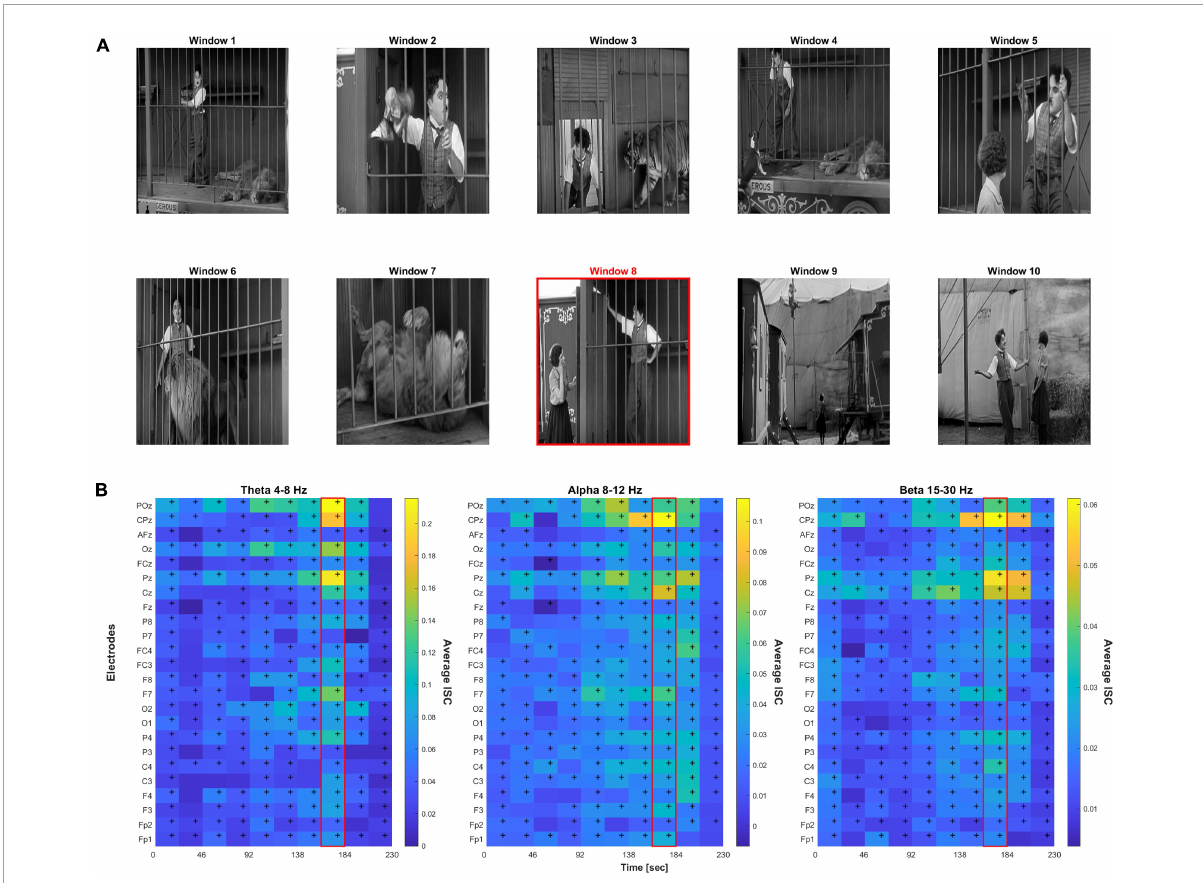
FIGURE1 (A) Screenshots representative of 10 time windows from the film. The red border indicates the peak 8th time window. (B) Heat map of the inter-subject correlation (ISC) values per electrode and time window across three frequency bands; peak ISC was observed in the 8th time window. Cells with “+” indicate FDR-corrected p < 0.05 significance relative to